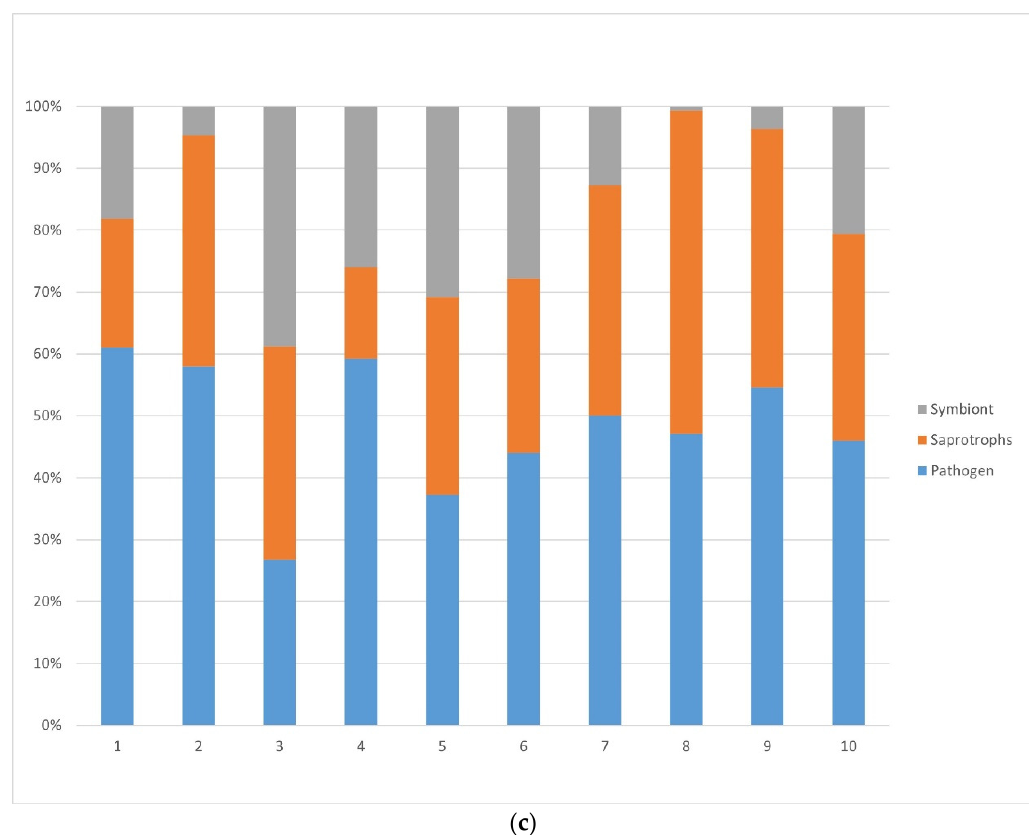
Figure 2. ( a ). Fungi ecological groups’ richness by sample. ( b ) Fungi phylum richness by sample. ( c ) Ecological groups’ abundance by sample.